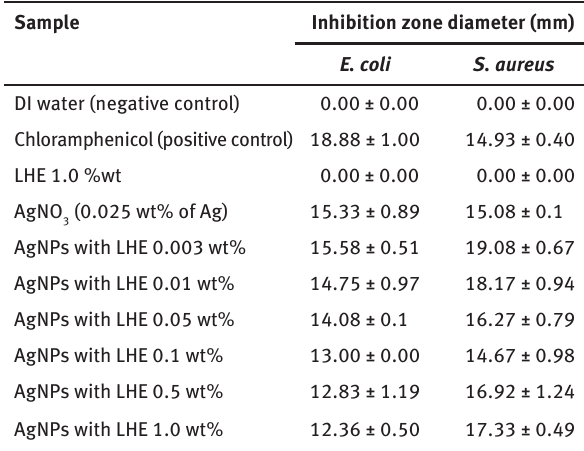
Table 2: The record of inhibition zone diameter (average value ± standard deviation) of all samples listed in Figure 9.